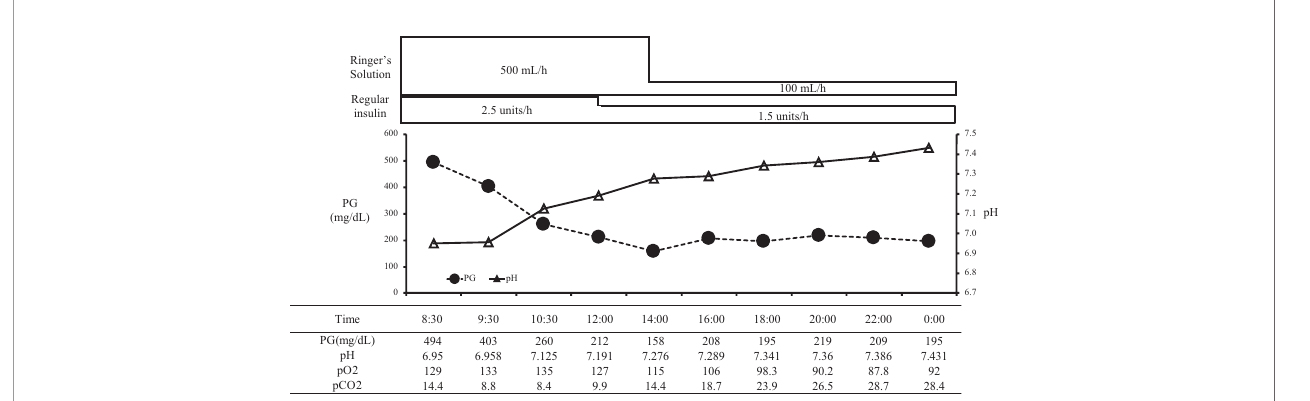
FIGURE 2 | The course in day1-2 in a patient with ketoacidosis who was treated with insulin. PG,